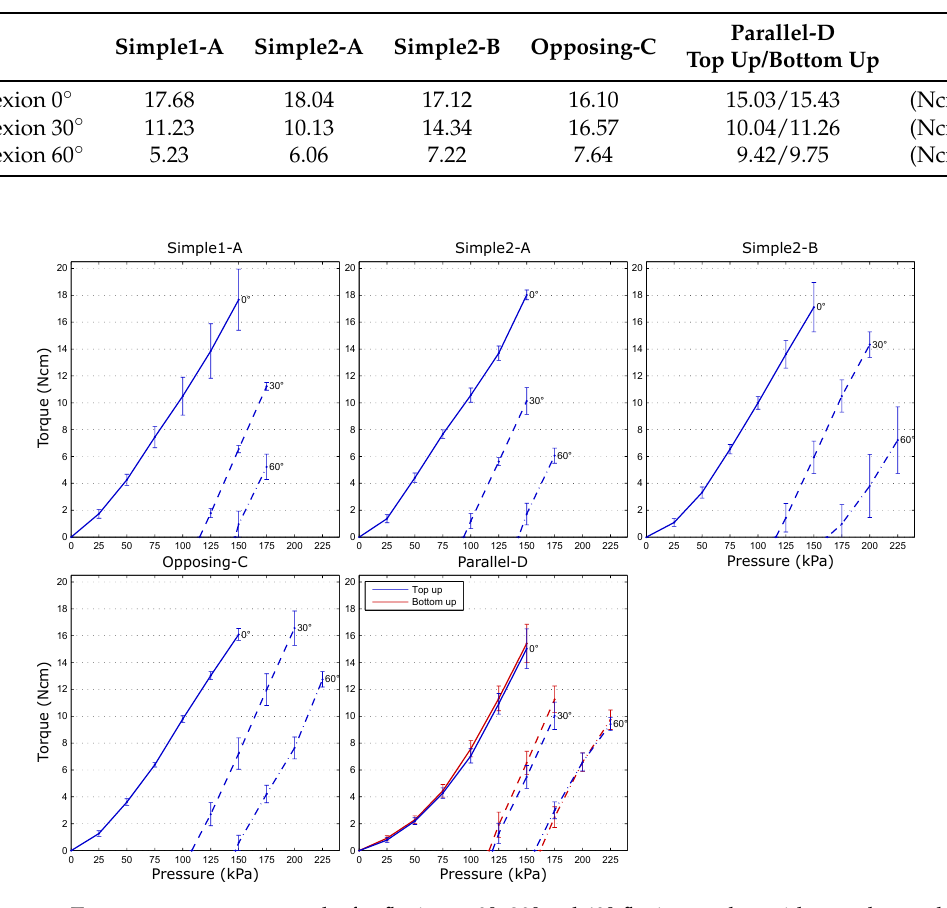
Figure 8. Torque measurement results for flexion at 0 ◦ , 30 ◦ and 60 ◦ flexion angles, with sample standard deviations. The maximum pressures for Simple1-A and Simple2-A were limited to avoid ballooning of silicone between the reinforcement helix on the back of the